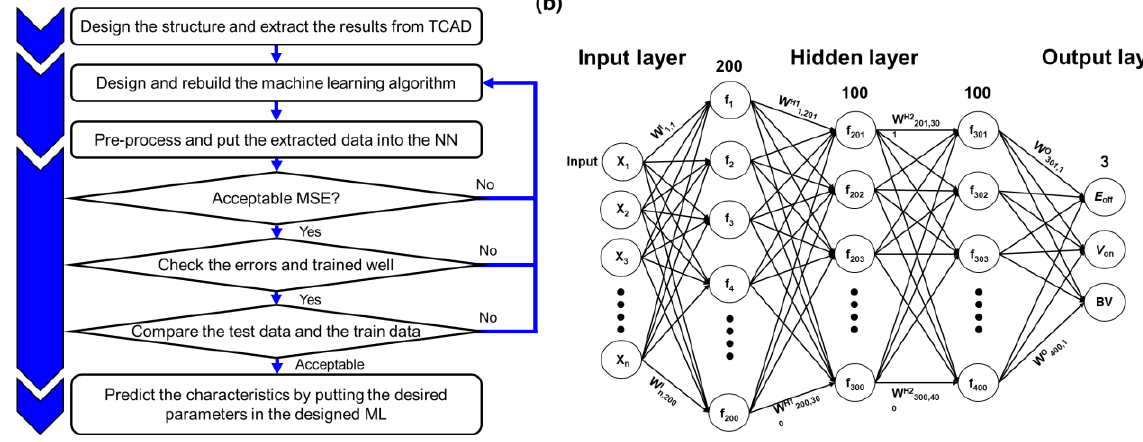
Figure 4. ( a ) The flow chart showing how to train the ML model and configuration of NN. ( b ) The model has 3 hidden layers (200-100-100) and extracts 3 output ( E off , V on , BV)